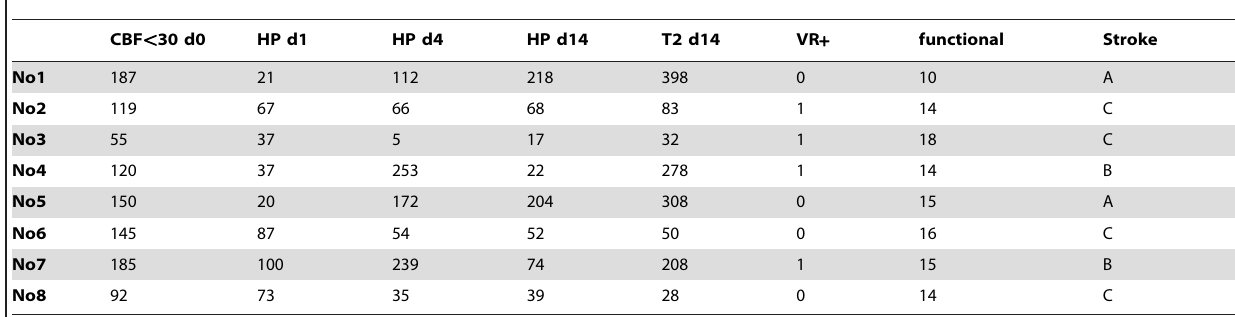
Table 1. Lesion characteristics and functional test scores in individual